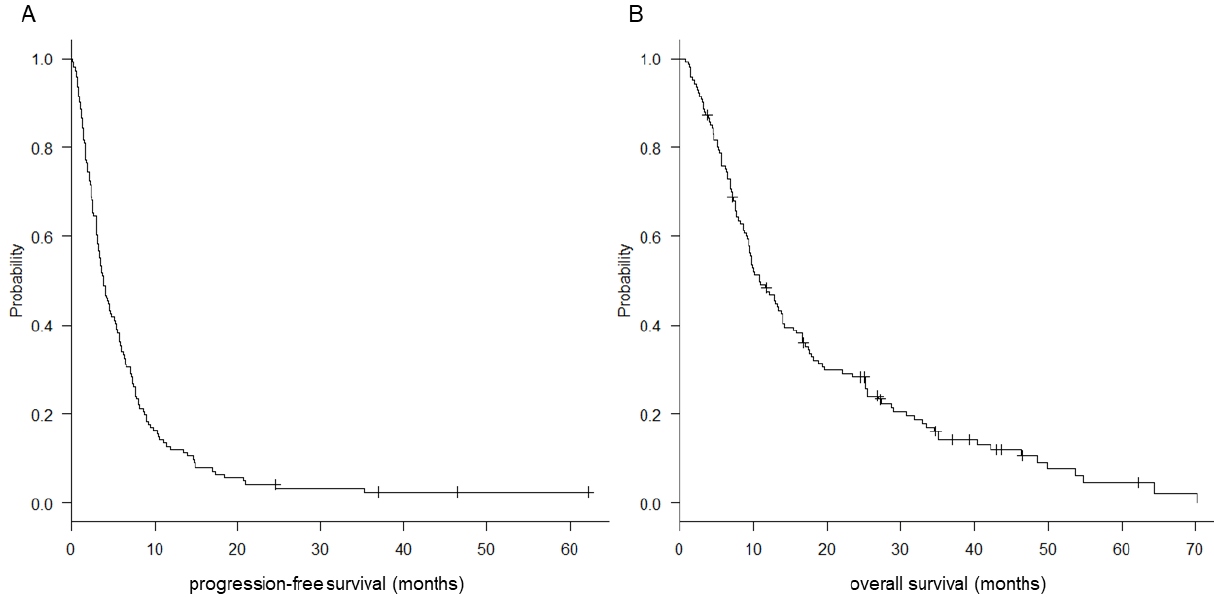
Figure 1. Kaplan–Meier curves for progression-free ( A ) and overall ( B ) survival of patients treated with pazopanib for non-round cell soft-tissue sarcoma ( n = 141). Table 3. Univariate and multivariate analyses of factors associated with durable clinical benefit.